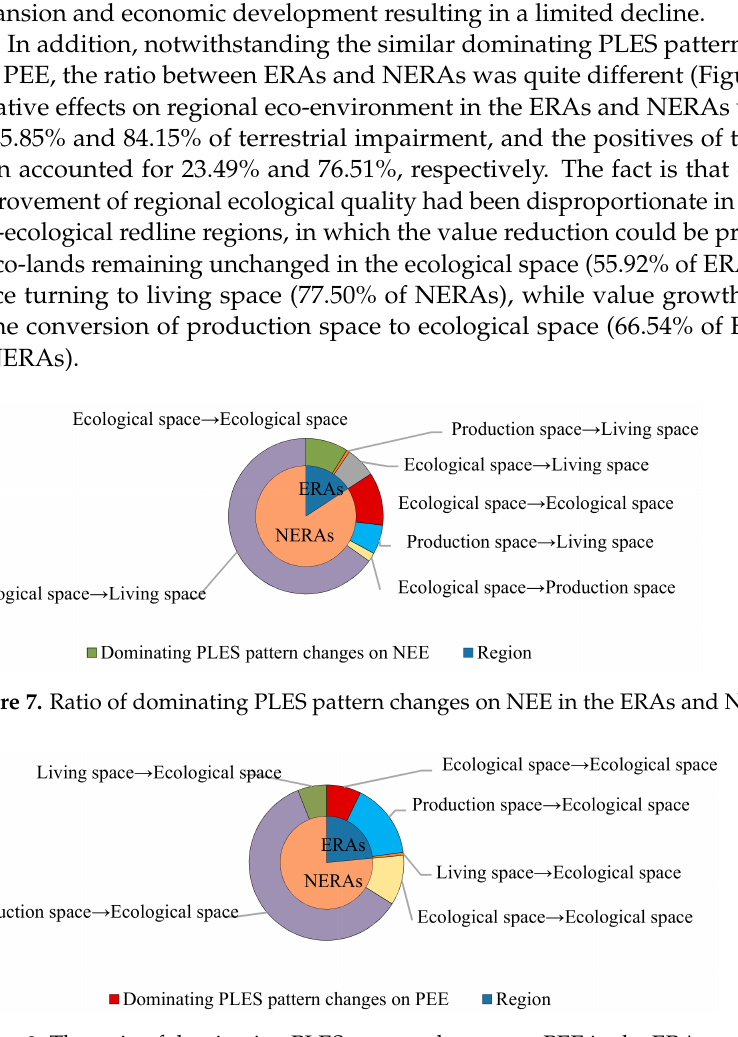
Figure 8. The ratio of dominating PLES pattern changes on PEE in the ERAs and